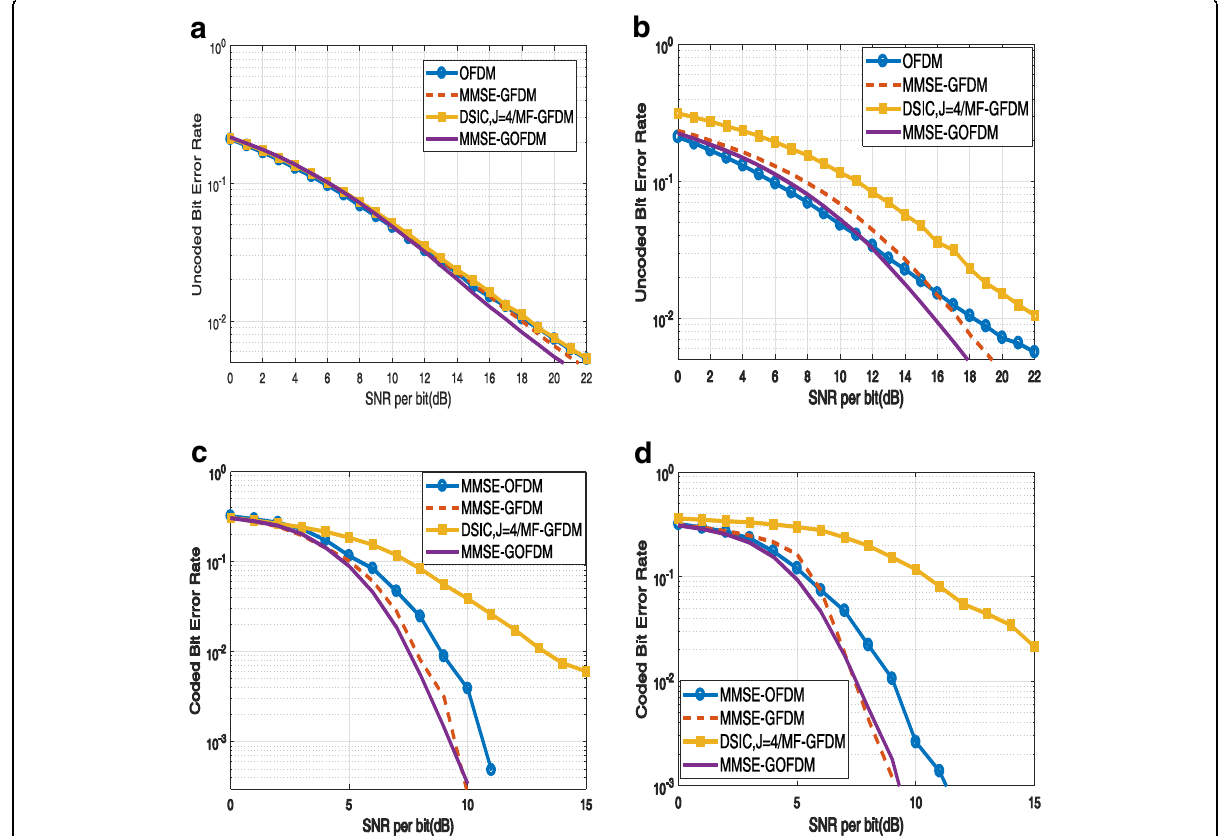
Fig. 10 Comparison of BER in multipath fading channel for 16-QAM where configuration is case 1 ( a , c ) and case 2 ( b , d